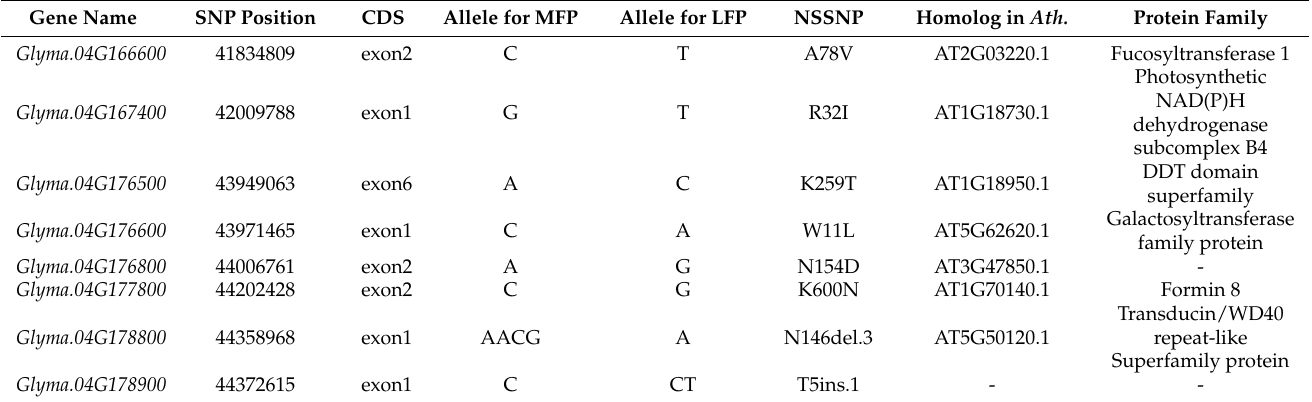
Figure 5. The distribution of ED-associated values on chromosome 4. Note: The color dots represent the ED value of each SNP ( a ) or Indel ( b ) locus. The higher the ED value the better the correlation.